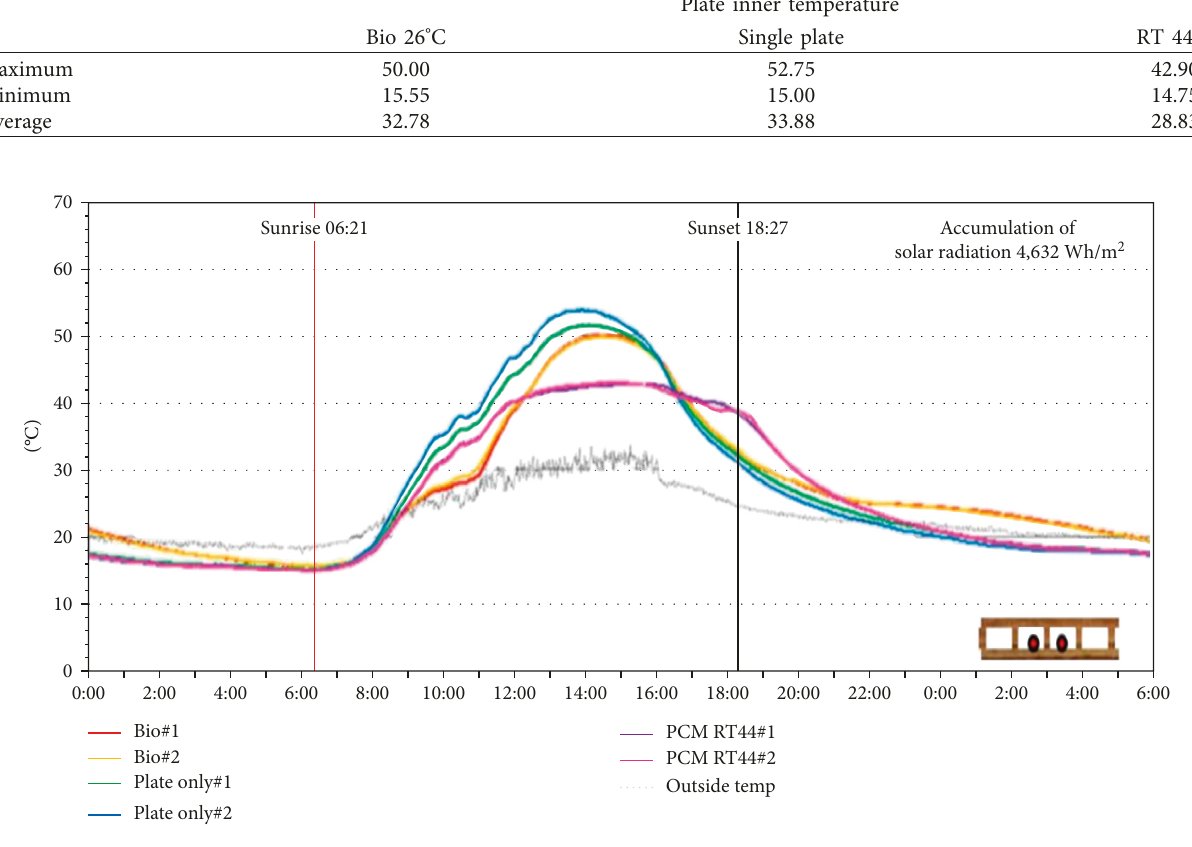
Figure 5: Plate inner temperature graph of Test 1.